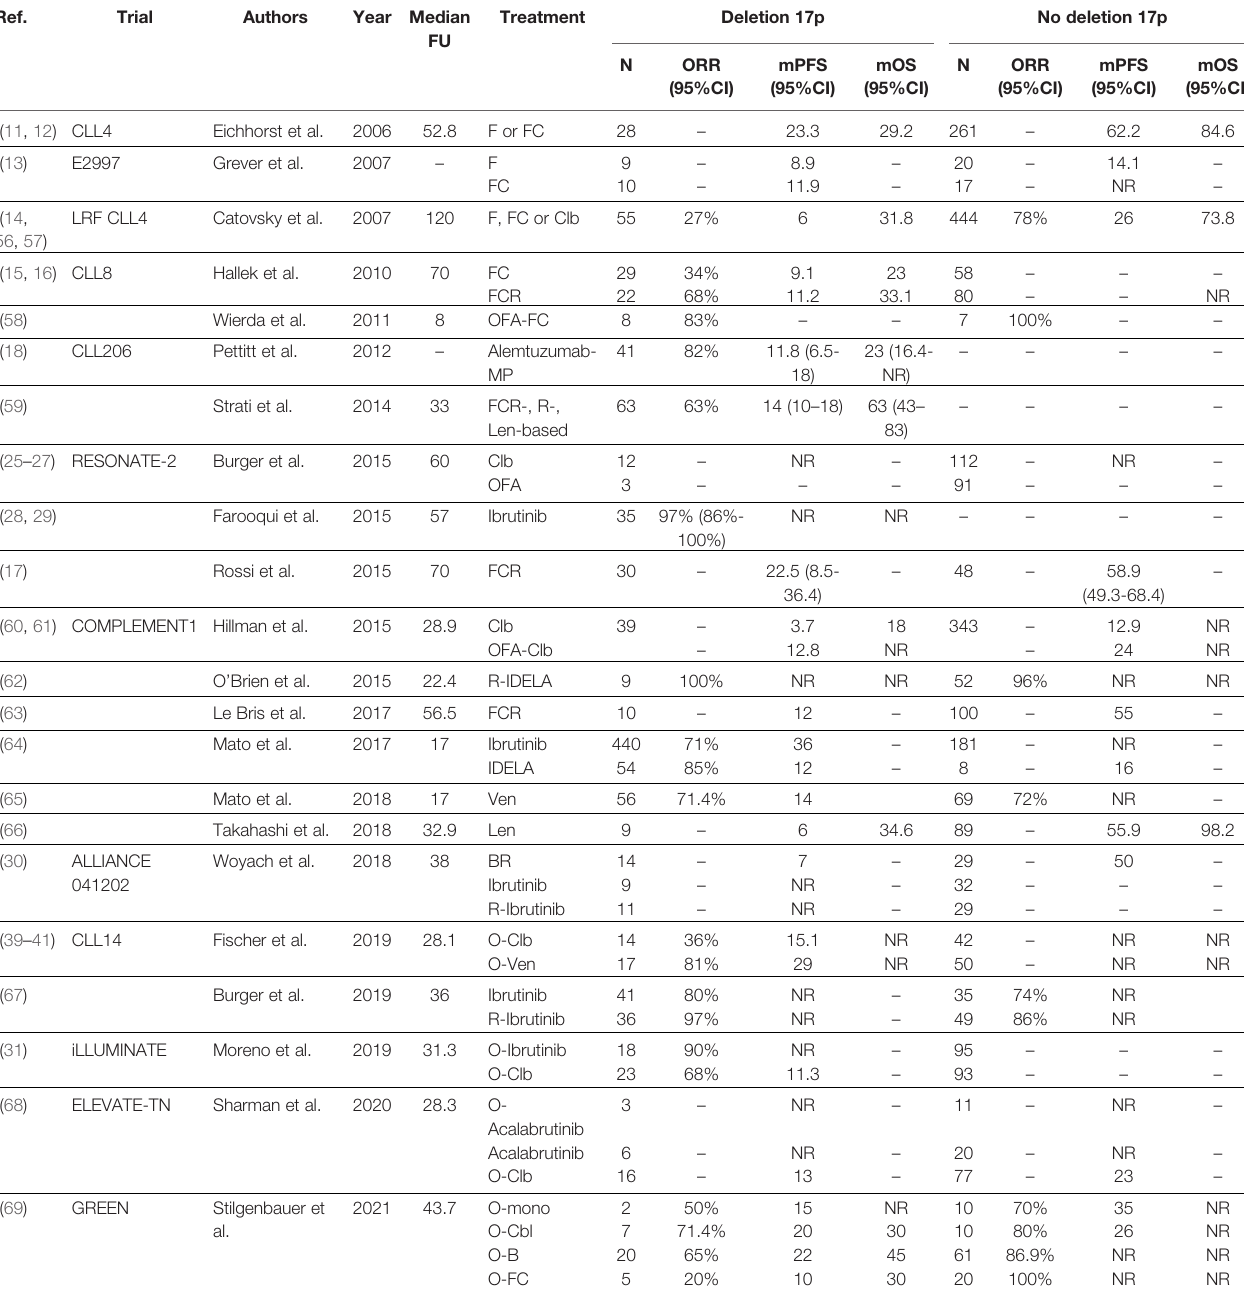
Allfollow-upisreportedinmonths.95%CI,95%con fi denceinterval;B,bendamustine;BR,bendamustine-rituximab;Clb,chlorambucil;F, fl udarabine;FC, fl udarabine;cyclophosphamide; FCR, fl udarabine; cyclophosphamide and rituximab; FU, follow-up; IDELA, idelalisib; Len, lenalidomide; MP, methylprednisolone; mOS, median overall survival; mPFS, median progression-free survival; NR, not reached; OFA, ofatumumab; O, obinutuzumab; ORR, overall response rate; R, rituximab; Ven,